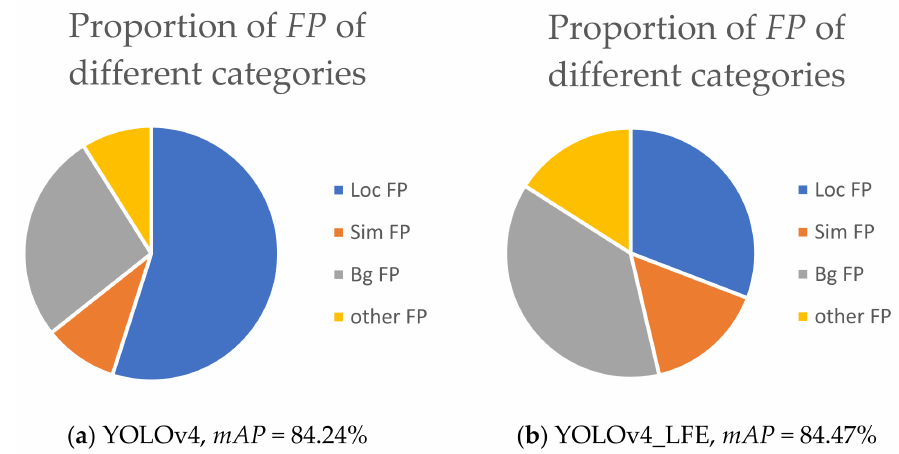
Figure 6. Proportion of FP in different categories.